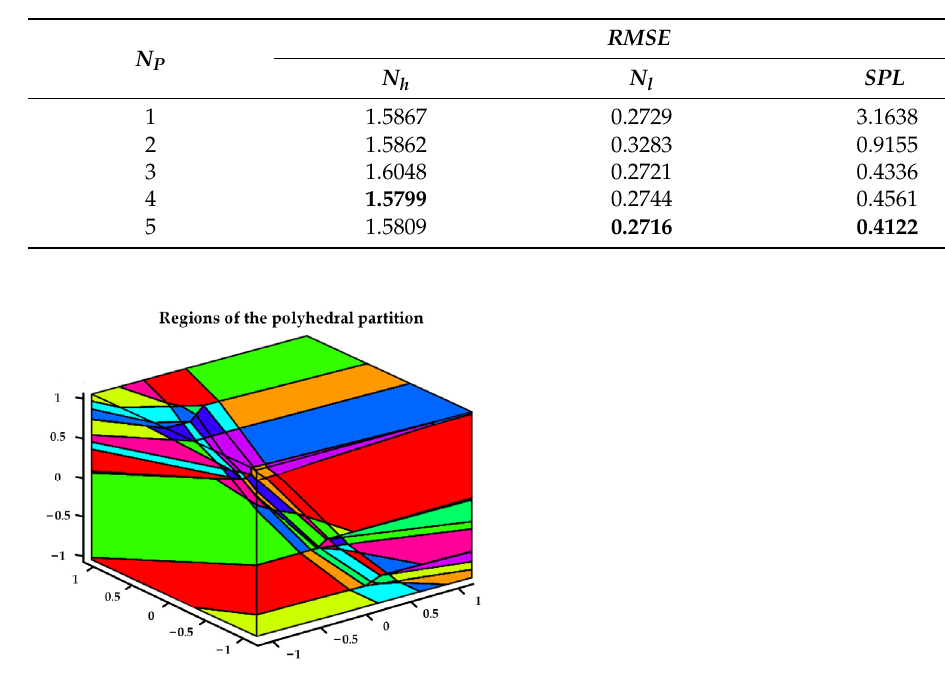
Figure 7. Regions of the polyhedral partition at the prediction horizon 5.